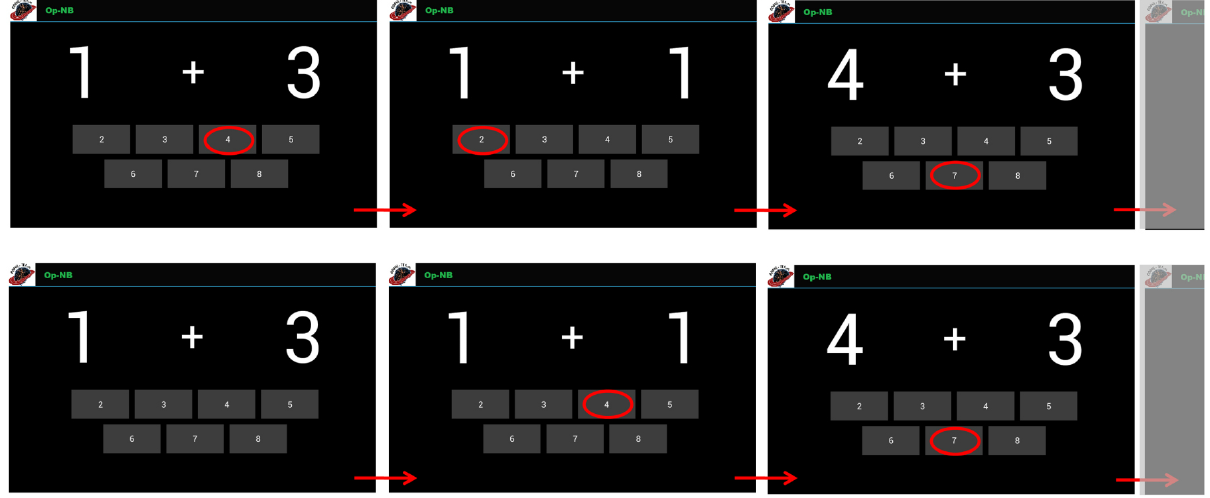
Figure 2. Examples of the operation N-back (Op-NB) exercises. The upper panel represents the operation 0-back (N=0) level of difficulty, whereas operation 1-back (N=1) is shown in the bottom panel. All the digits from 1 to 9 can appear on the screen and, consequently the sums range from 2 to 18. However, it is possible to reduce the difficulty of the task by limiting the digit span. Besides digit span, other task-specific parameters have to be taken into account such as the value of N (minimum 0; maximum not defined) and the rate of stimulus presentation. In Op-NB, adaptive working load algorithms operate only on N and rate of stimulus presentation.